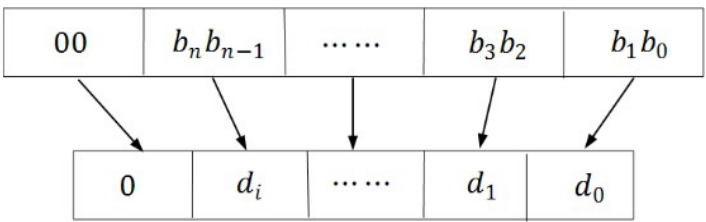
Figure 5. Morton code.